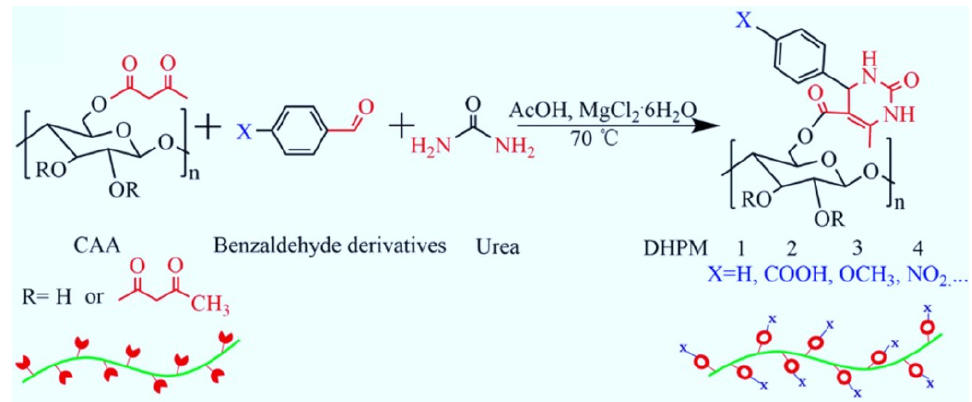
Figure 11. Modification of cellulose acetoacetate (CAA) via the Biginelli reaction. Reprinted with permission from ref. [59] . Copyright © 2019 Elsevier Ltd. All rights reserved.